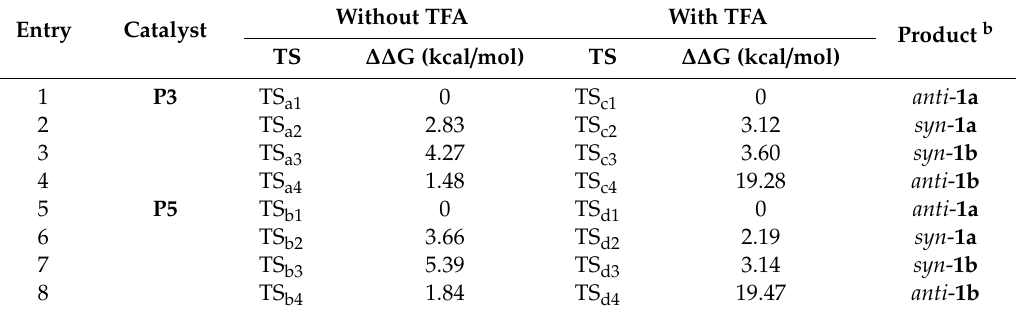
Table 3. The calculated relative energy barriers (ΔΔG) for the enamine/aldehyde reaction transition states in the aldol reaction of cyclohexanone with 4-nitrobenzaldehyde a .